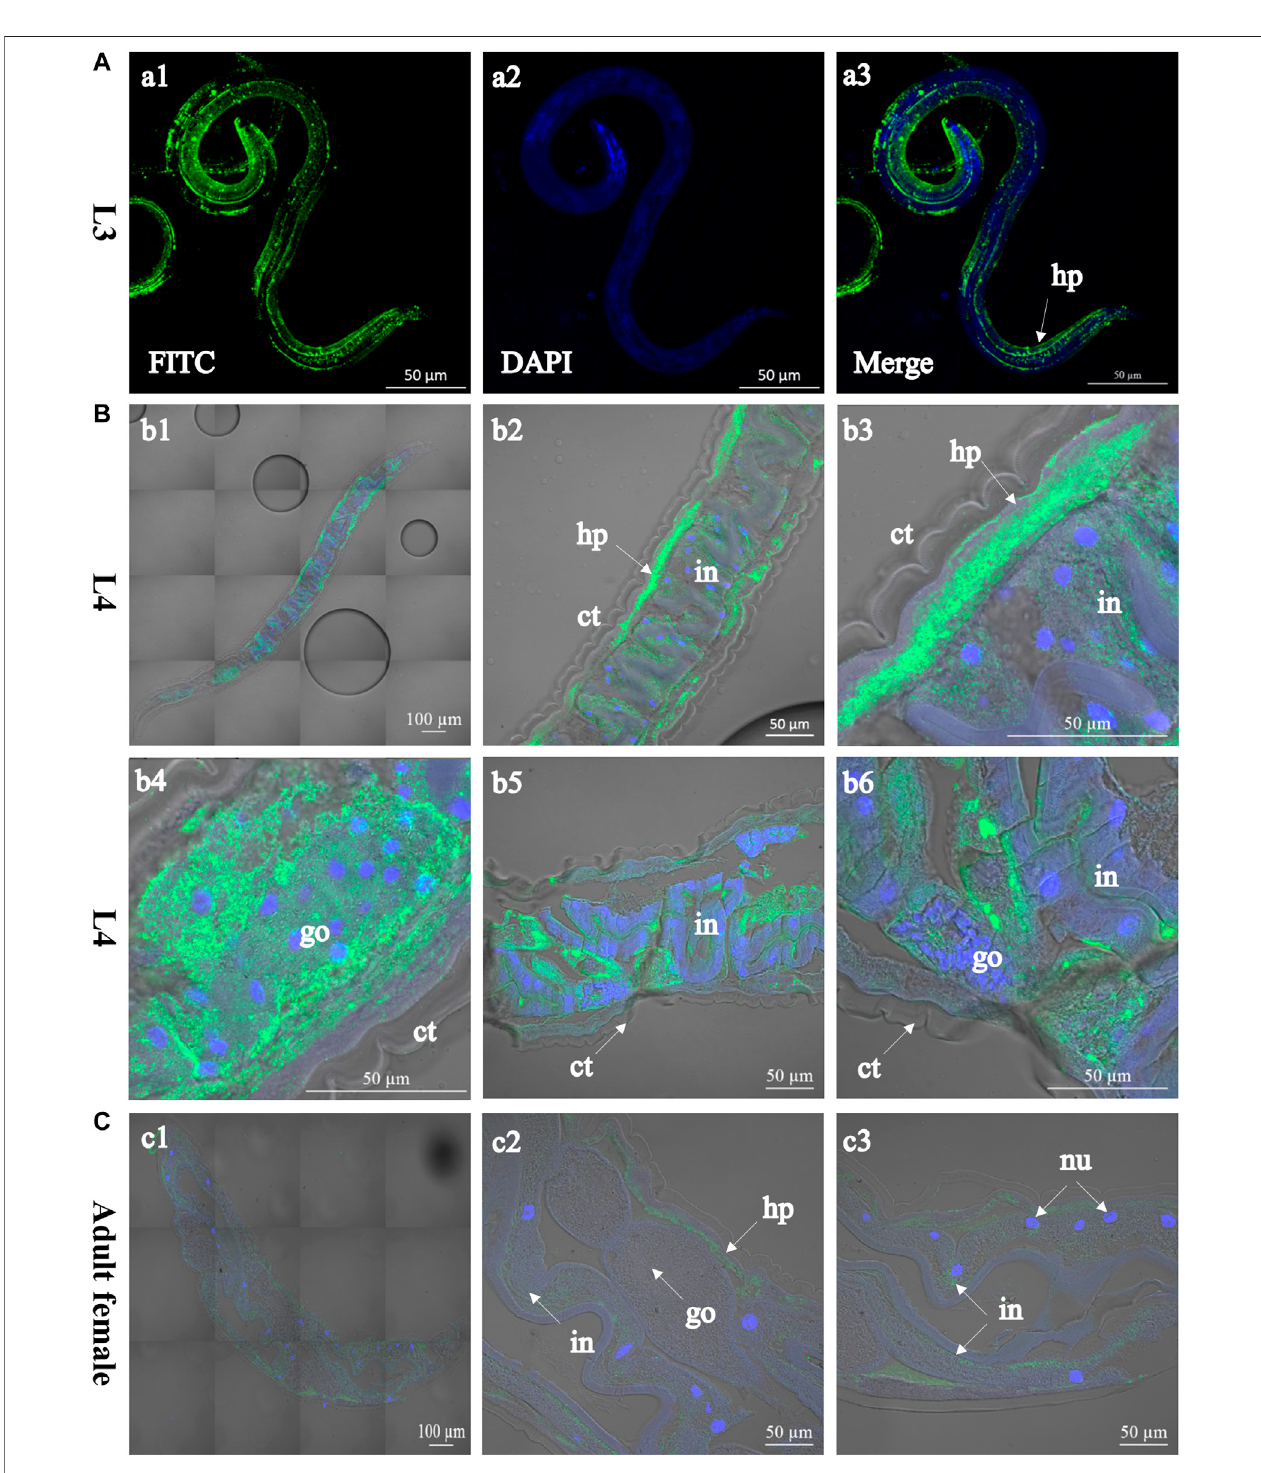
FIGURE2| Immunolocalisation of Hc -TTR-31 in Haemonchus contortus . Green fl uorescence shows the distribution of Hc -TTR-31 in the third- (A) and fourth stage larvae (B) , and adult stage (female) (C) of H. contortus . Hc -TTR-31 is probed with rabbit anti-r Hc -TTR-31 polyclonal antibodies followed by fl uorescein (FITC) conjugated-goat anti-rabbit IgG as secondary antibody. Nuclei are stained with 4 ′ ,6-diamidino-2-phenylindole (DAPI). ct: cuticle, go: gonad, in: intestine, hp: hypodermis, nu: nucleus. Scale bar: 50 μ m or 100 μ m.